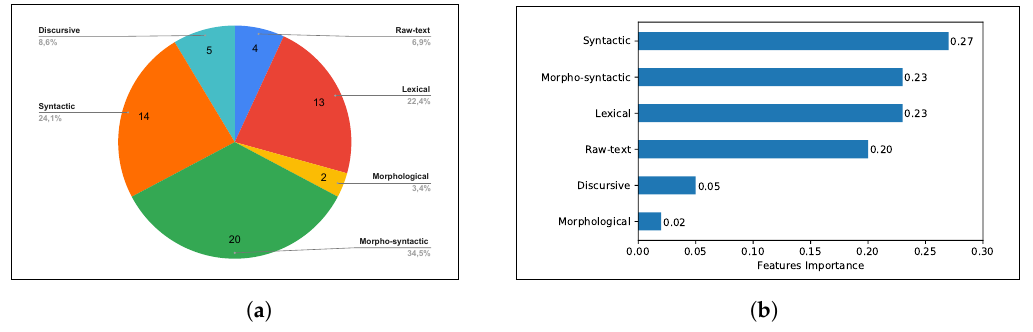
Figure 4. Impact of the different categories of features. ( a ) Features category distribution in the random forest (RF) model. ( b ) Features importance in the RF model.